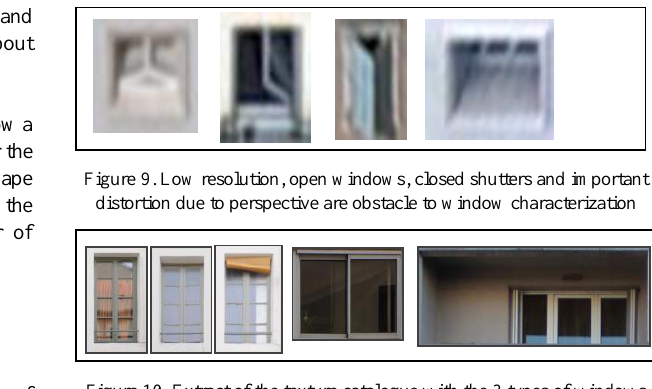
Figure 10. Extract of the texture catalogue with the 3 types of windows (old, new and loggia).